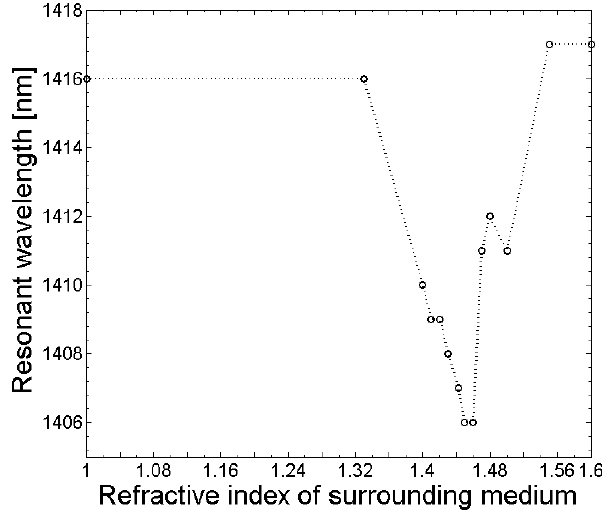
Figure 13. Dependence of the resonant LPG wavelength on the refractive index of the fiber surroundings.